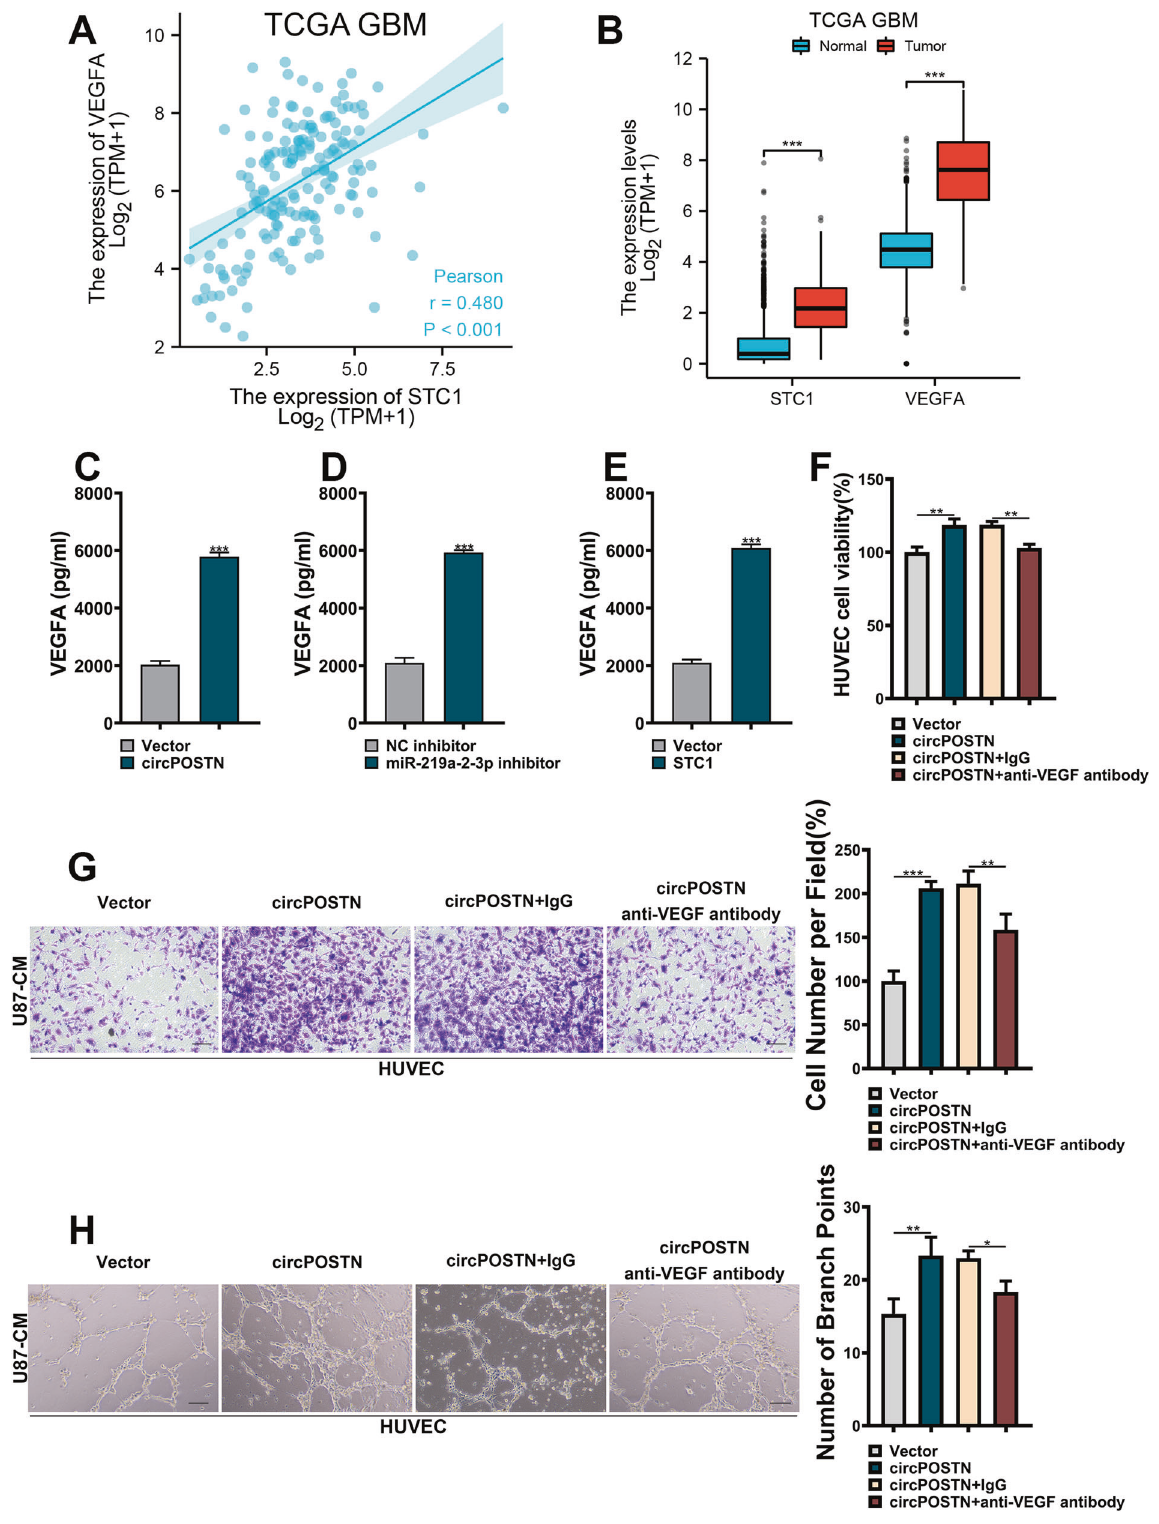
Fig. 6 CircPOSTN upregulates STC1 and promotes GBM proliferation, migration, and neovascularization. A The expression association between STC1 and VEGFA was analyzed based on the TCGA GBM cohort. B The expression levels of STC1 and VEGFA were obtained from the TCGA GBM cohort. C – E The VEGFA levels from the culture medium of U87 cells were detected by ELISA. U87 cells were transfected with circPOSTN overexpressing vectors ( C ), miR-219a-2-3p inhibitors ( D ), STC1 overexpressing vectors ( E ), or the corresponding controls. F – H The U87 cells were transfected with circPOSTN overexpressing or empty control vectors. Then, the HUVECs were cultured in the conditioned medium from U87 cells incubated with anti-VEGF or anti-IgG antibodies. F The MTT measurement of cell proliferation. G The transwell migration assays were conducted to determine the cell migration capacity. H The tubule formation assays showing the pro-angiogenic effects of U87 cells. Data are presented as the mean ± SD. * P < 0.05, ** P < 0.01, *** P < 0.001. NS not signi fi